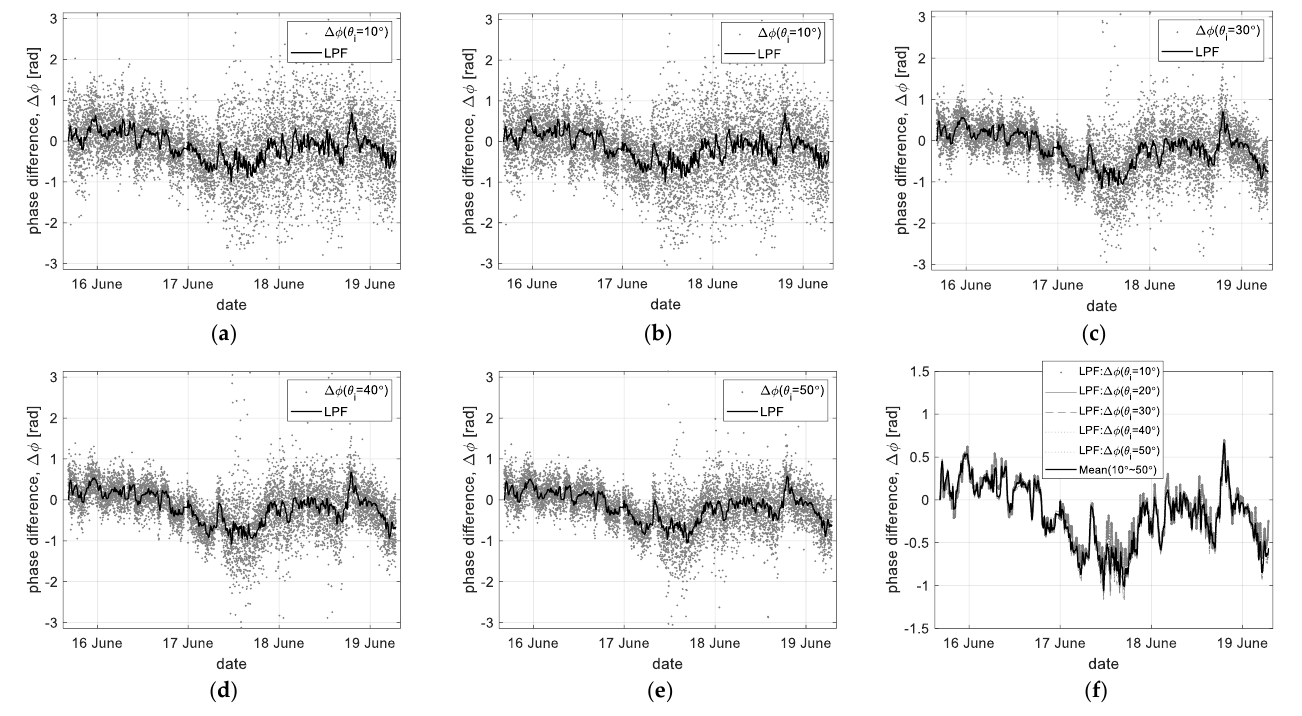
Figure 6. Time-series self-interferometric phase data ( ∆Φ ) and its low-pass filtered data (‘LPF’): ( a – e ) the original & filtered data at each incident angle, and ( f ) the comparison of all ‘LPF’ data.